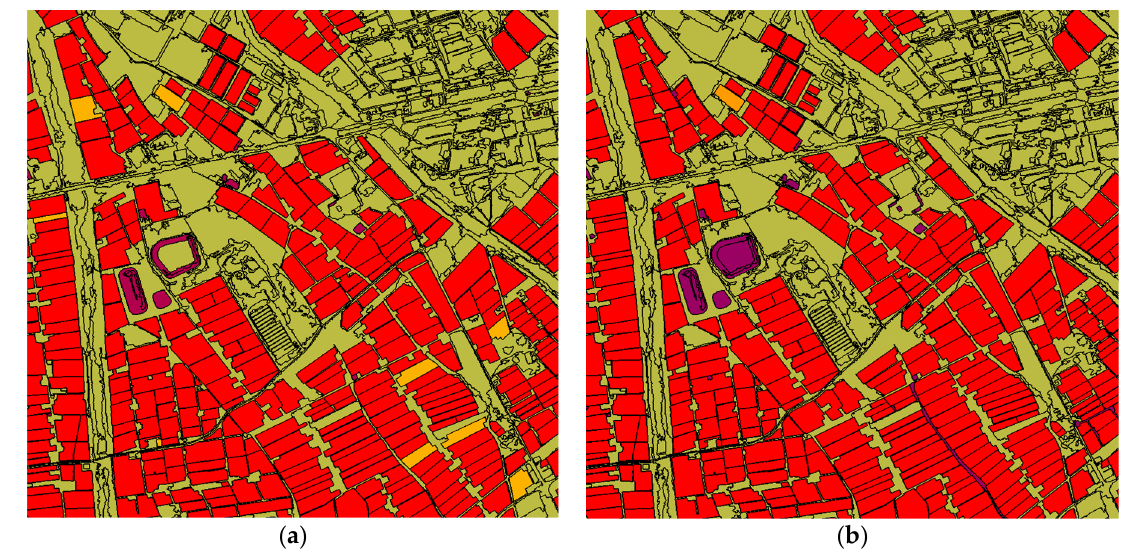
Figure 6. Pixel-based accuracy assessment over a detailed area (2000 m × 2000 m): ( a ) Classification results using the DT model for All Features strategy; ( b ) classification results using the NDPI_B index. The GH class is represented in red and the Non-GH class is represented in green. Yellow (GH classified as Non-GH) and purple (Non-GH classified as GH) colors in both classification maps highlight the misclassification errors. Table 6. Pixel-based confusion matrices from ground truth (TTA Mask) for the DT based on the NDPI_B index.